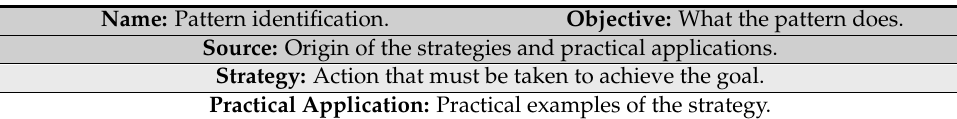
Table 6. Template of the strategic patterns.